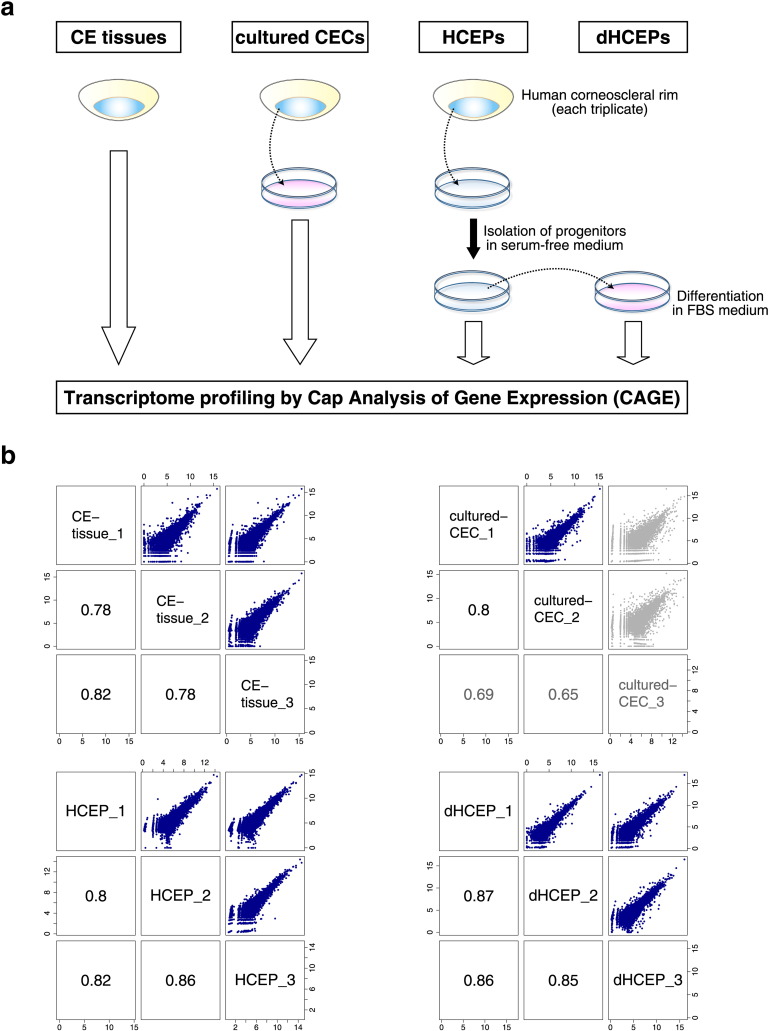
Study design and quality check.(a) Study design. Corneal endothelia were dissected from corneoscleral rims derived from three donors for each type of sample: corneal endothelial (CE) tissues, cultured corneal endothelial cells (CECs), and corneal endothelial progenitor cells (HCEPs). For CE tissues, RNA was extracted directly from dissected corneal endothelium. For cultured CECs, RNA was extracted from CECs after ex vivo expansion. HCEPs were isolated in serum-free culture media (shown in blue) and differentiated into mature CECs (dHCEPs) by being cultured in differentiation media containing fetal bovine serum (shown in red). RNA was extracted from both HCEPs and dHCEPs. Each RNA sample was processed and analyzed by CAGE. (For interpretation of the references to color in this figure legend, the reader is referred to the web version of this article.)(b) Correlation analysis of promoter activities between each triplicate. Each number represents the Spearman's rank correlation coefficient. Numbers and dots shown in gray indicate low correlation of “cultured-CEC_3” expression profiles with those of the other two cultured CEC samples. The x- and y-axes represent log2-scaled expression values (tpm) for each promoter.